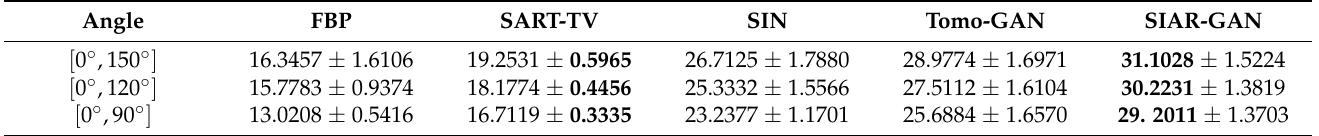
Figure 9. A partial enlarged comparison of different methods using partially enlarged image from the red box area in Figure 7. The layout is consistent with Figure 7. Table 1. Average PSNR results (mean ± standard deviation).